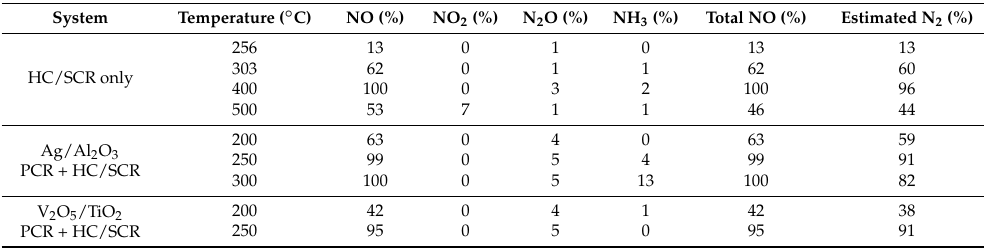
Table 6. Conversion of NO and yields of NO 2 , N 2 O, and NH 3 during the reduction of NO over